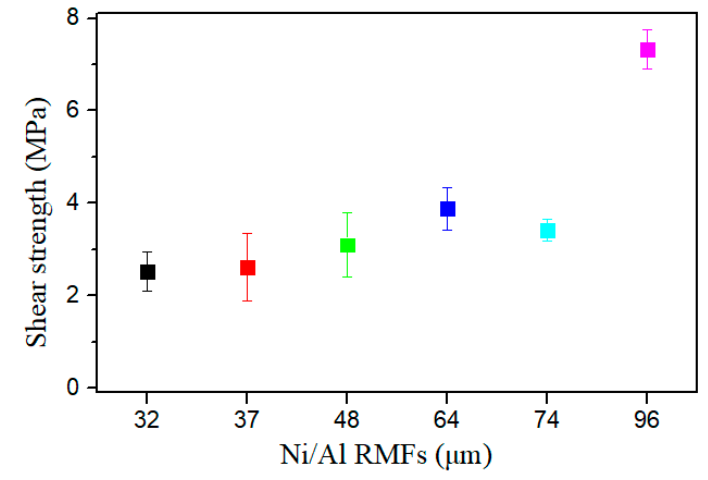
Figure 7. Shear strength of the joints using RMFs with different thicknesses.